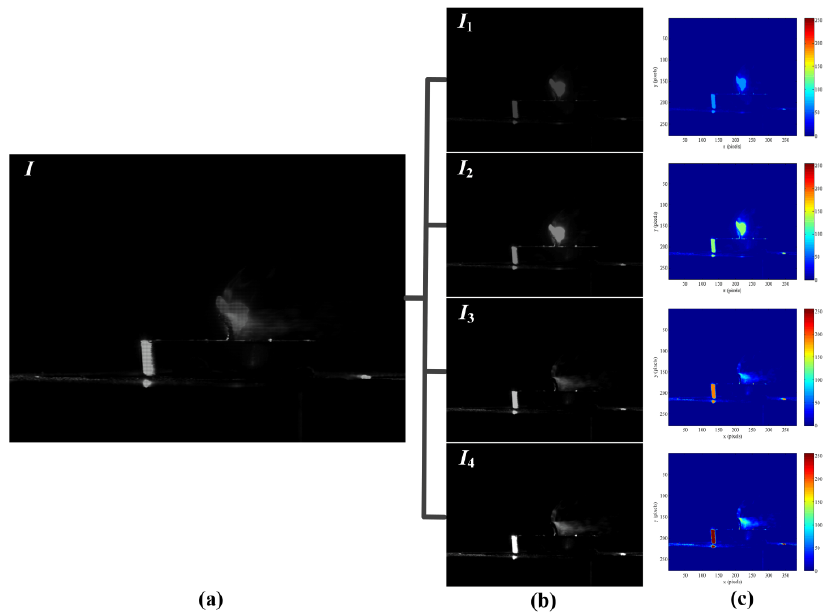
Figure 10. The second example result of coded exposure for the motion of the candles flame. ( a ) Coded exposure image I ; ( b ) Subframes: I 1 , I 2 , I 3 , I 4 ; ( c ) Light intensity distribution of candle flame. Sensors 2016 , 16 , 331